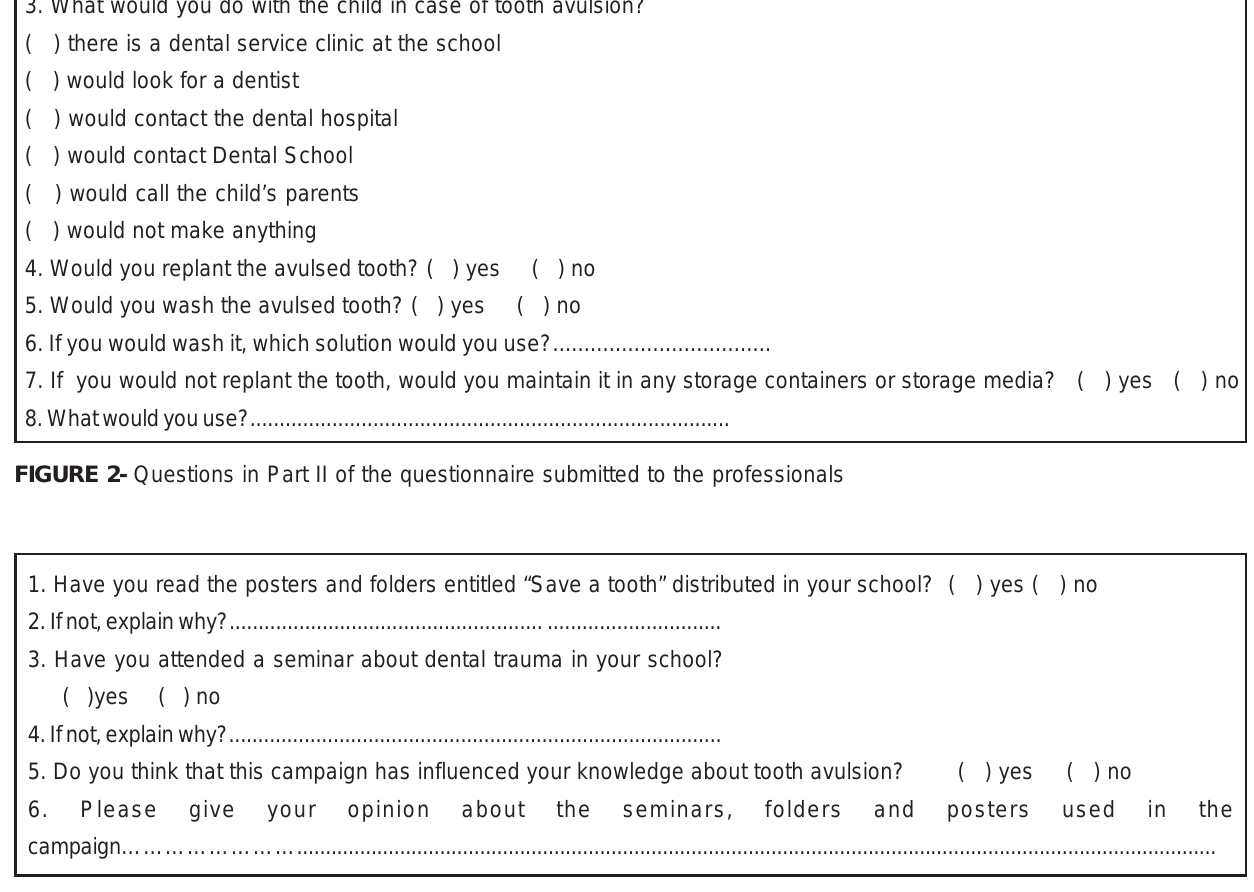
FIGURE 3- Questions in Part III of the questionnaire submitted to the professionals